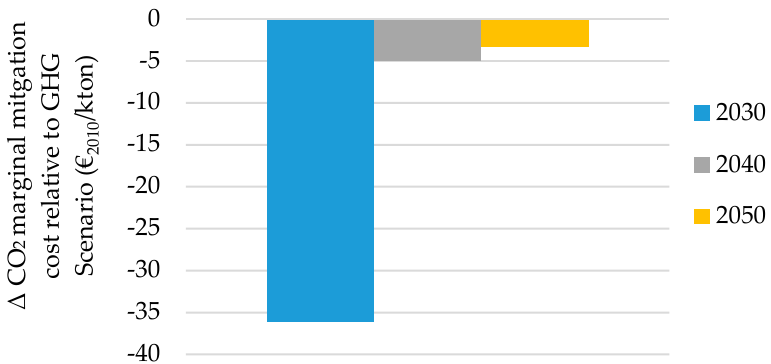
Figure 4. Difference in marginal CO 2 mitigation cost in greenhouse gas damage (GHG_DAM) scenario and greenhouse gas (GHG) scenario in the EU28 (€2010/kton).